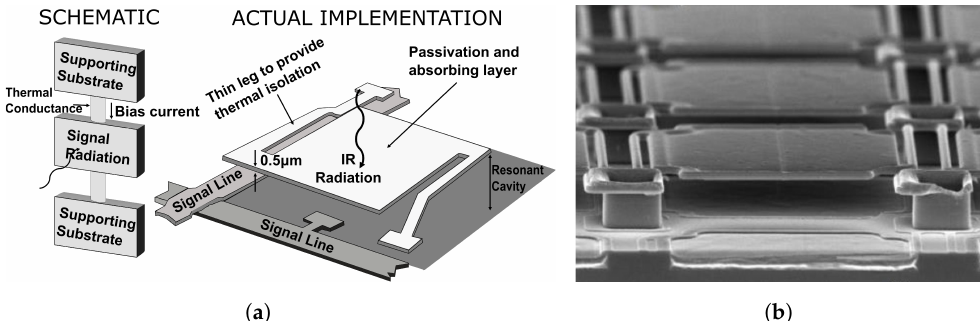
Figure 3. ( a ) Microbolometer structure and Schematic model, ( b ) Microbolometer scanning electron microscope (SEM) image